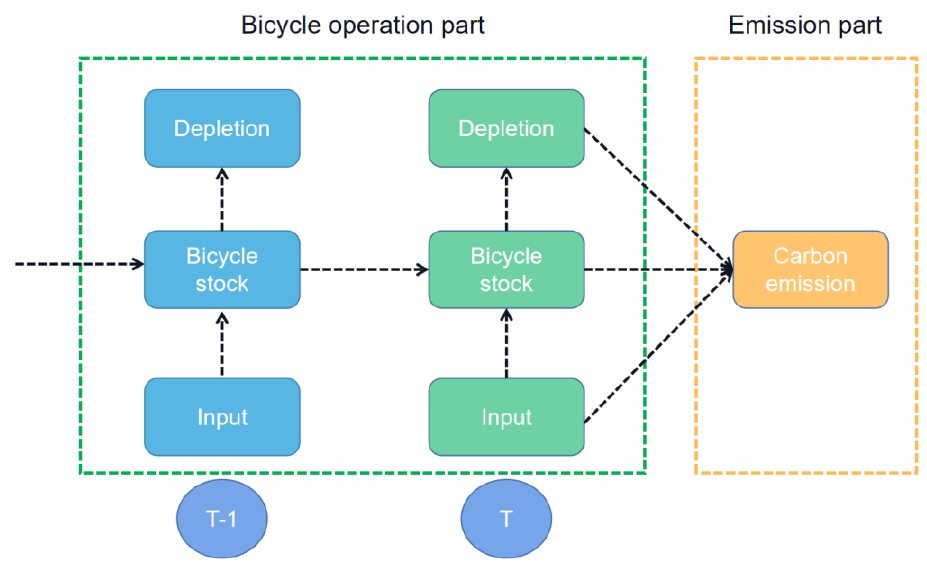
Figure 2. Carbon emission model.